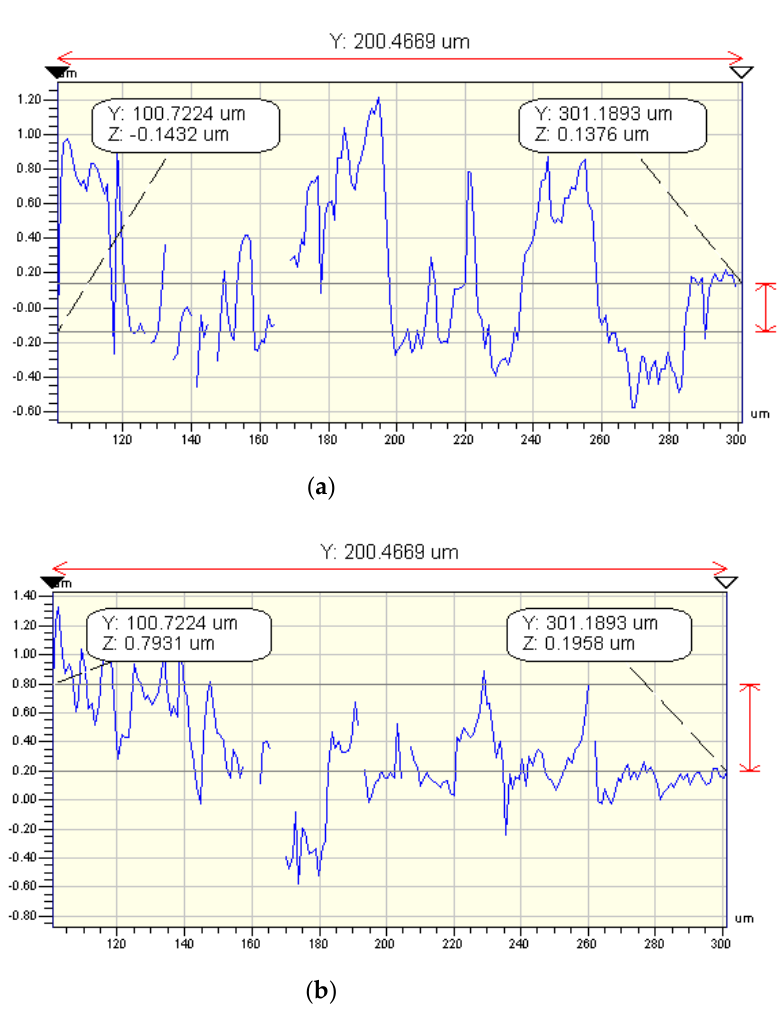
Figure 14. Surface roughness of KMN-I specimens. ( a ) Large specimen; ( b ) welded specimen. Table 4. Fatigue strength of Murakami model and related